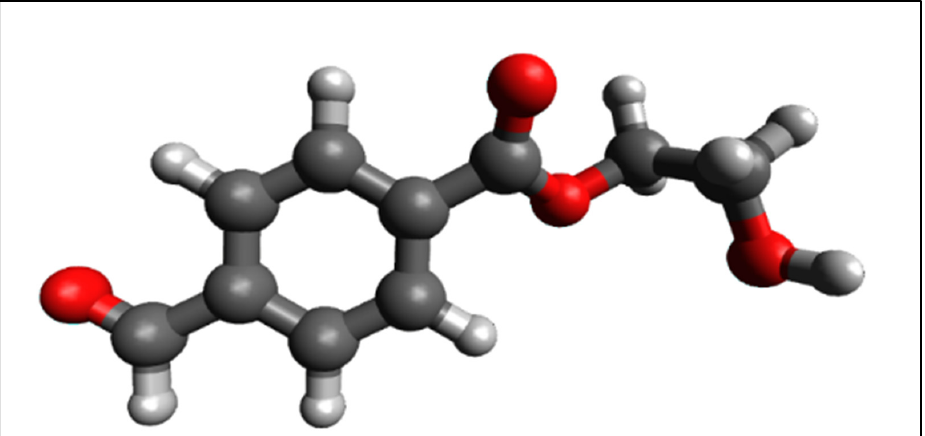
Figure 2. 3D model of the PET molecular structure. The polymeric chain is formed by linking successively this monomer (repeat unit) about 100 times on average. The model was produced by the Avogadro molecule editor [40].